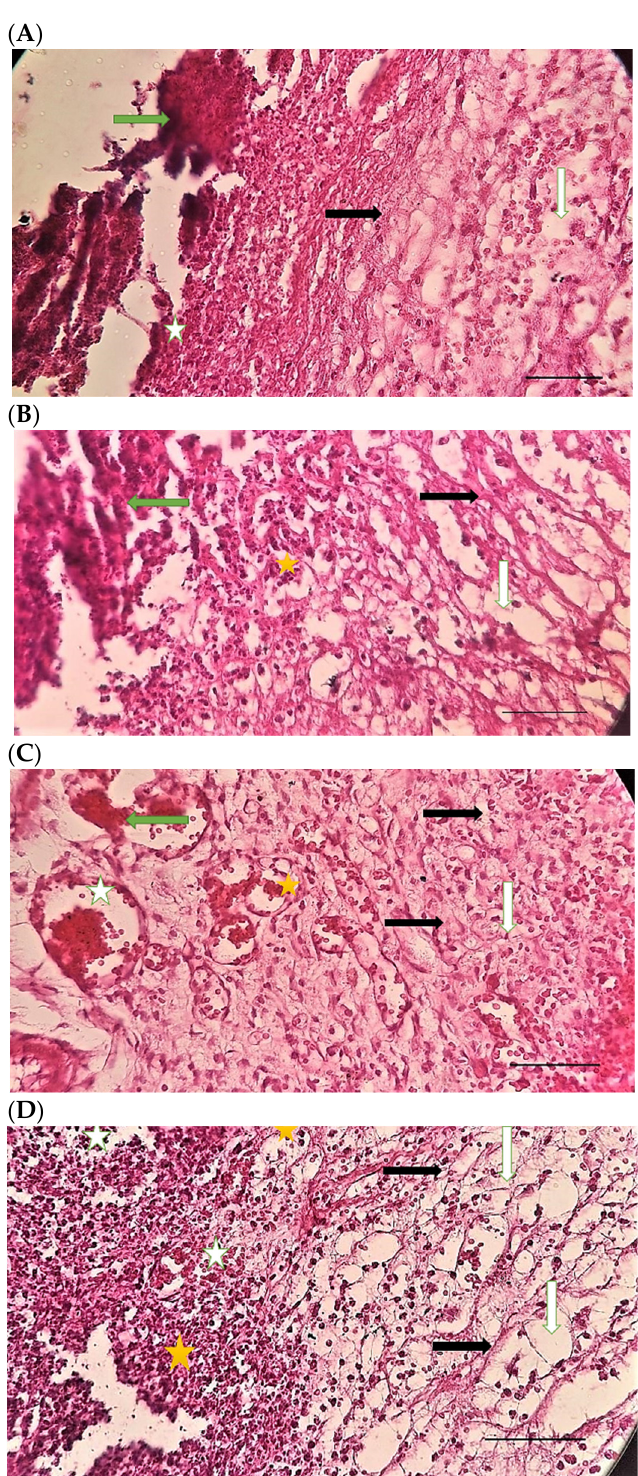
Figure 6. H&E stained microscopic sections (Bar = 100 μm) wound in rats on day 3 of the study. ( A ) Control group; Hemorrhage (white star), lack of collagen fibers formation (black arrow), edema (white arrow). ( B ) Ch group; Edema (white arrow), thin collagen fiber (black arrow), clot (green arrow), inflammation (yellow star). ( C ) ChSeN group; Severe hyperemia (white star), fine collagen fibers (black arrow). ( D ) ChSeND group; Edema (white arrow), hemorrhage (white star), fine collagen fibers (black arrow), inflammation (yellow star).